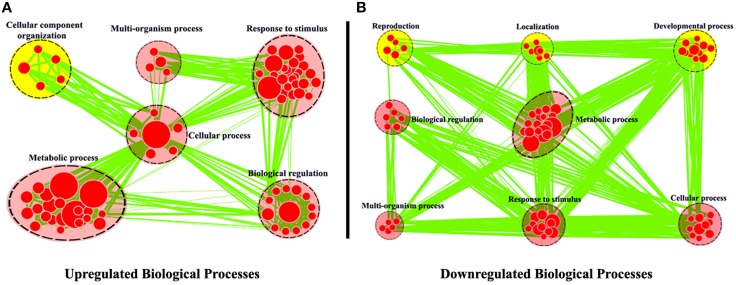
Biological Process analysis of differentially expressed genes between leaf and root tissues. GO modules enriched with up-regulated DEGs (A) and down-regulated DEGs (B) were visualized by the Enrichment Map in Cytoscape. The red and yellow circles indicate the common and different biological processes between up-regulated and down-regulated DEGs, respectively.